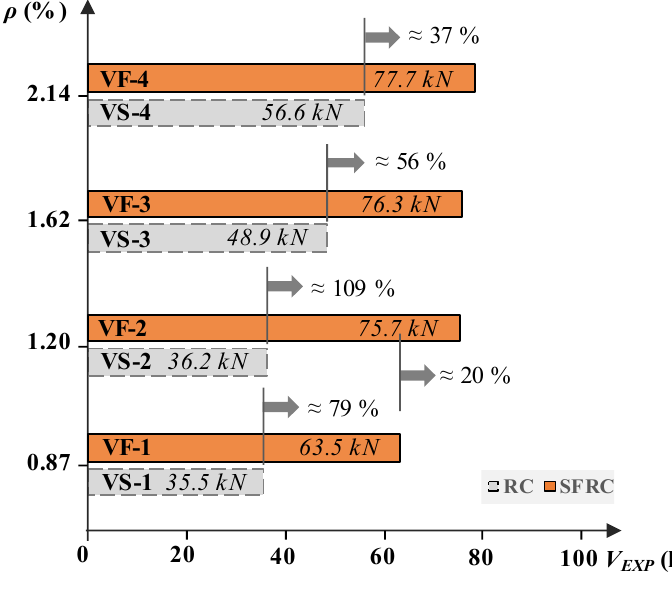
Figure 11. Shear strength of the beams and strength gain.